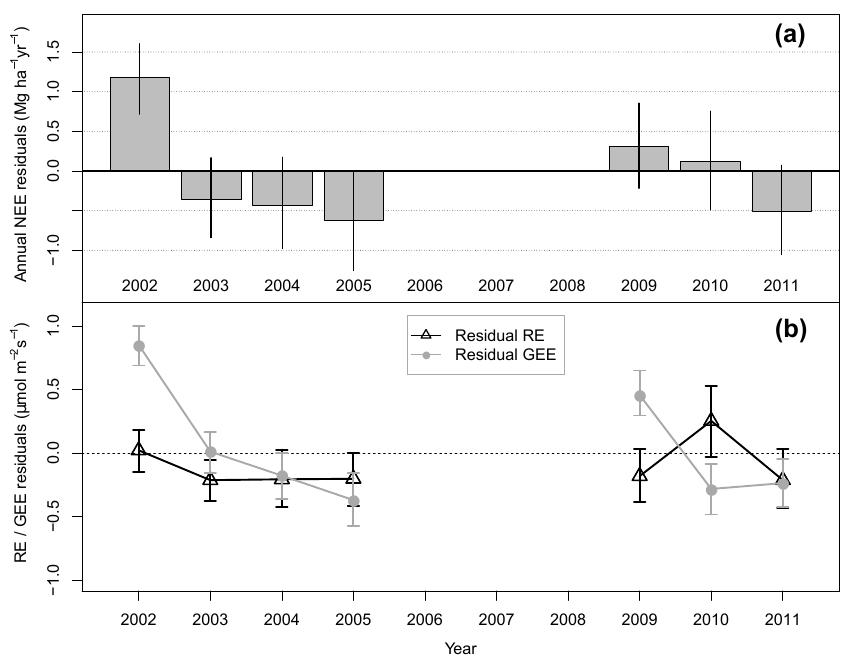
Figure 7. (a) Annually summed model residuals. Error bars are 95% bootstrapped confidence intervals. Annual residual NEE in 2002 is statistically different from 0 within random NEE measurement error; all other years are not. (b) Residuals of model representation of partitioned GEE (gray circles) and RE (black